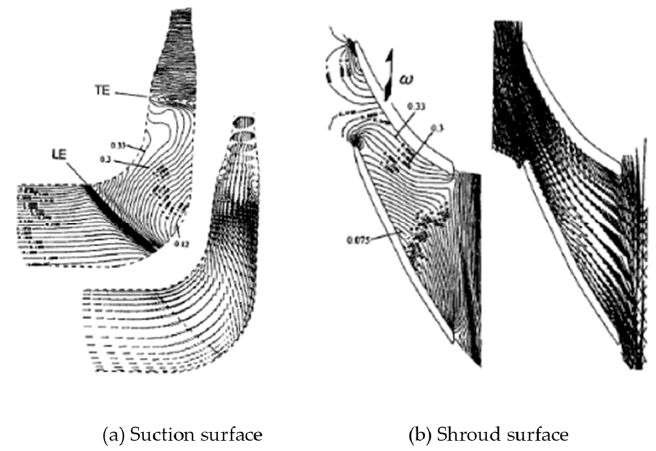
Figure 3. Simulated velocity vectors and reduced static pressure on both the suction surface and shroud surface of the blade [43].